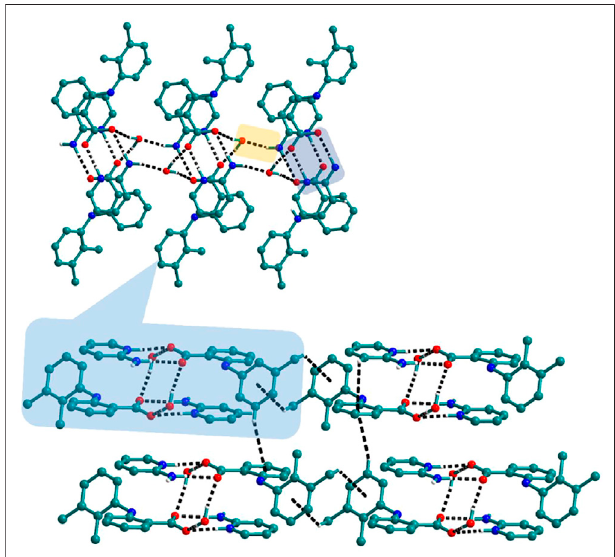
FIGURE 9 | In 10 , The dimers of Mef ─ 2ap are connected with other dimers through N ─ H ··· O forming columns. These columns further connect with other columns via C ─ H ··· π to form a 3D network.